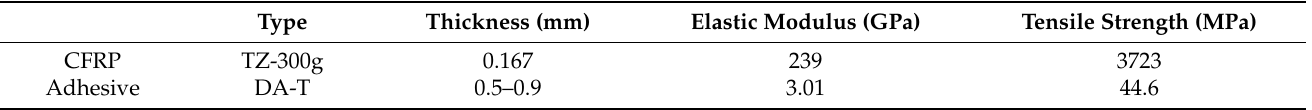
Table 2. Mechanical properties of CFRP and adhesive.